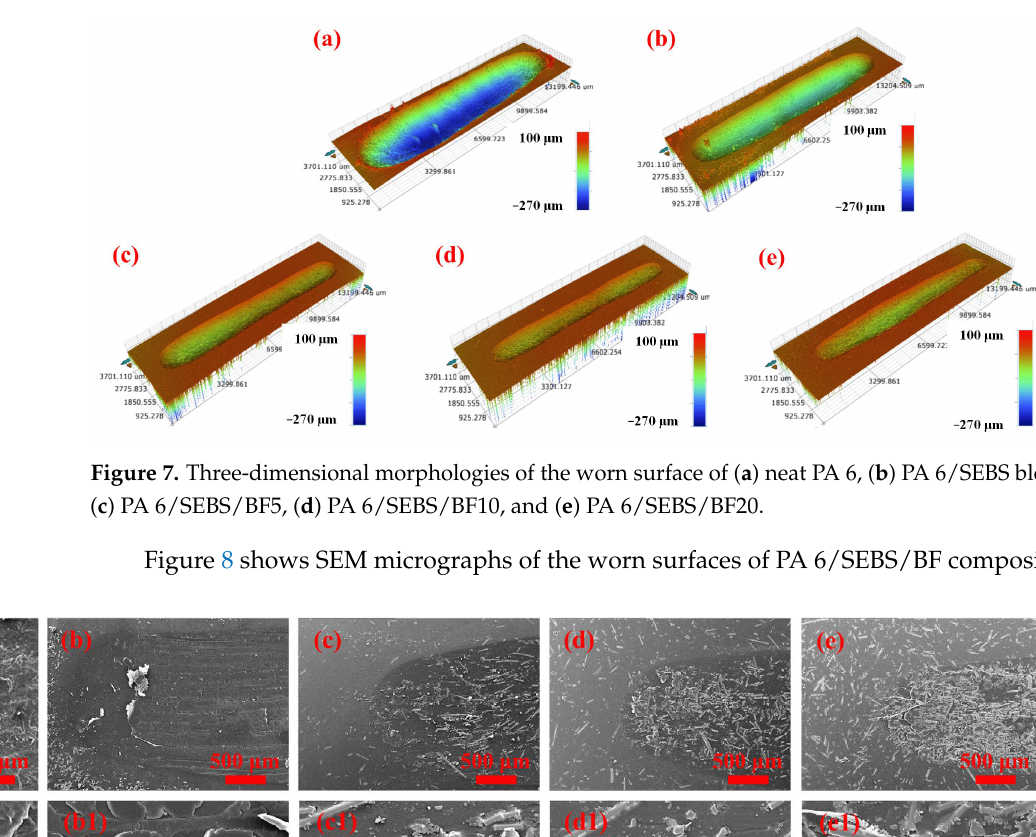
Figure 7. Three-dimensional morphologies of the worn surface of ( a ) neat PA 6, ( b ) PA 6/SEBS blend, ( c ) PA 6/SEBS/BF5, ( d ) PA 6/SEBS/BF10, and ( e ) PA 6/SEBS/BF20.